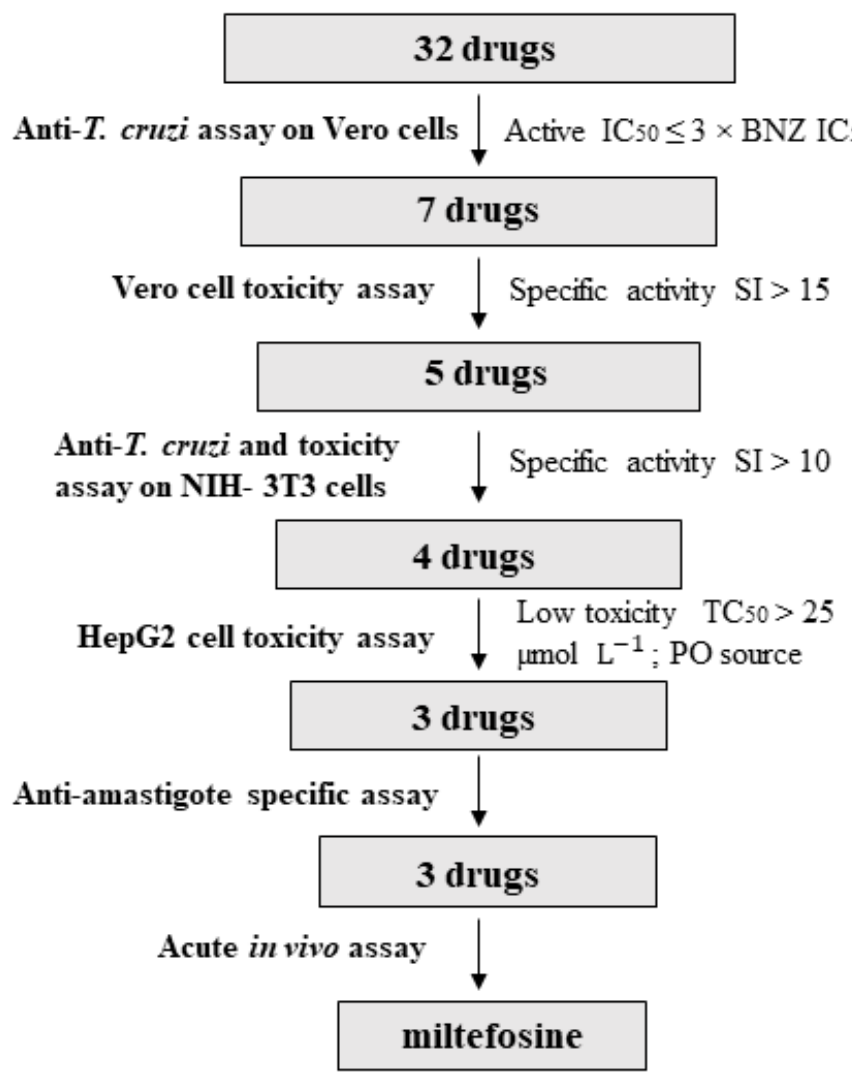
Figure 4. Flow-chart depicting the study drug progression steps (SI, selectivity index; PO, per oral source).